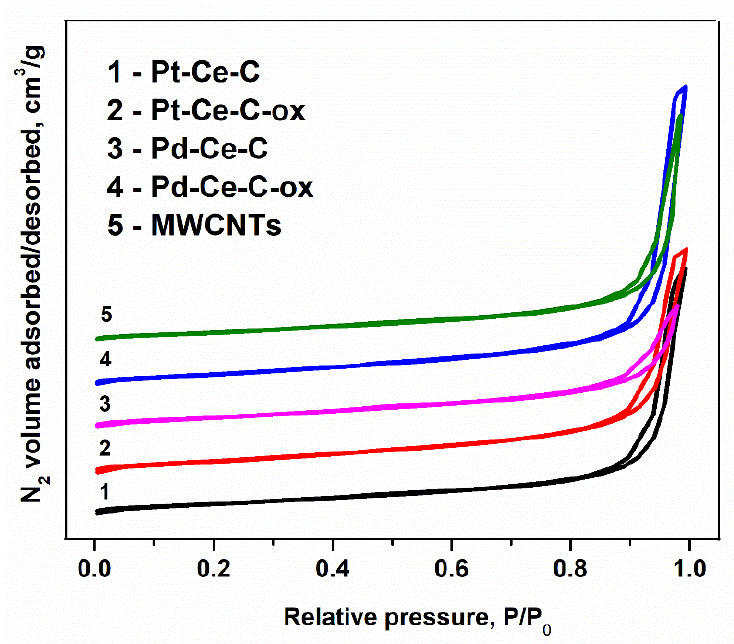
Figure A1. Nitrogen adsorption–desorption isotherms for the samples.